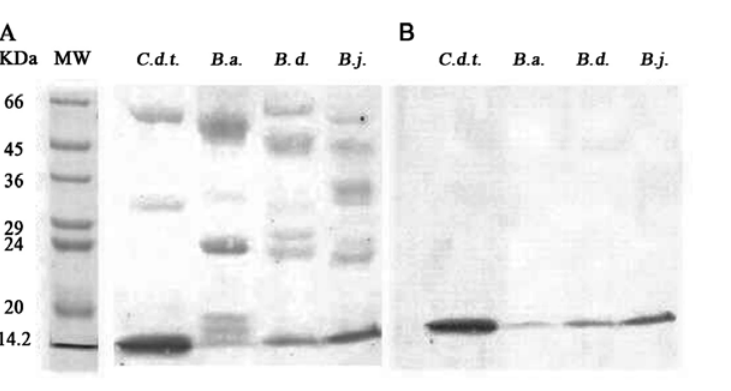
Figure 2. Venom cross-reactivity determined by immunoblotting. ( A ) SDS-PAGE of bothropic and crotalic venoms. ( B ) Immunoblotting showing the reactivity of C.d.t. venom and bothropic venoms to IgG anti- C .PLA 2